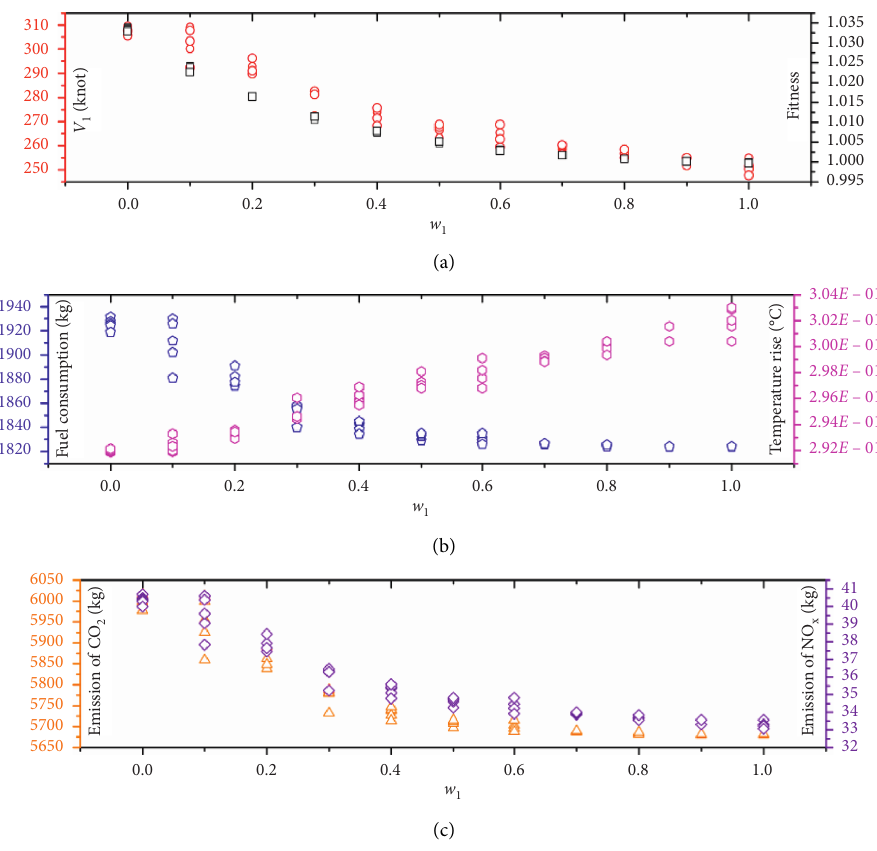
Figure 9: Influence of objective weight on optimization